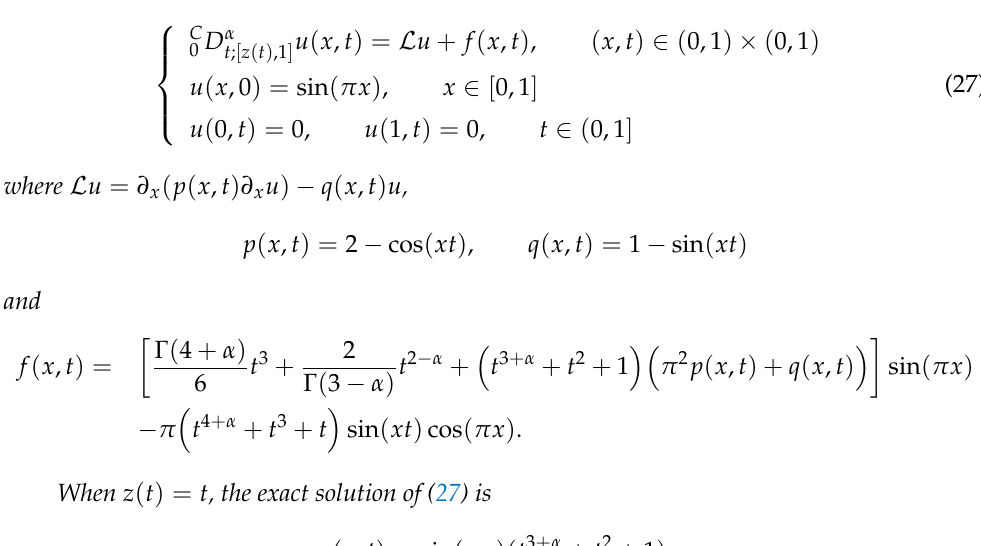
Table 4. (Example 2) Temporal convergence order when α = 0.5, h = 1